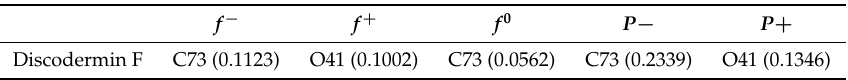
Figure A5. Graphical sketches of the local reactivity descriptors for Discodermin E showing the reactivity regions: ( a ) Electrophilic Fukui Function f − , ( b ) Nucleophilic Fukui Function f + , ( c ) Radical Fukui Function f 0 , ( d ) Electrophilic Parr Function P − and ( e ) Nucleophilic Parr Function P + . Table A6. Condensed local reactivity descriptors for Discodermin F denoting the reactivity sites: Electrophilic Fukui function f − , Nucleophilic Fukui function f + , Radical Fukui Function f 0 , Electrophilic Parr Function P − and Nucleophilic Parr Function P +